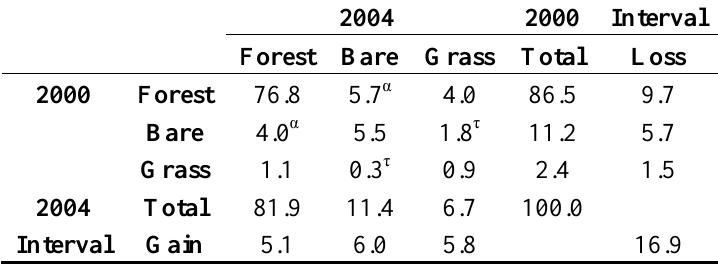
Table 1. Transitions as a percent of the domain. Superscript α indicates a systematically avoiding transition. Superscript τ indicates a systematically targeting